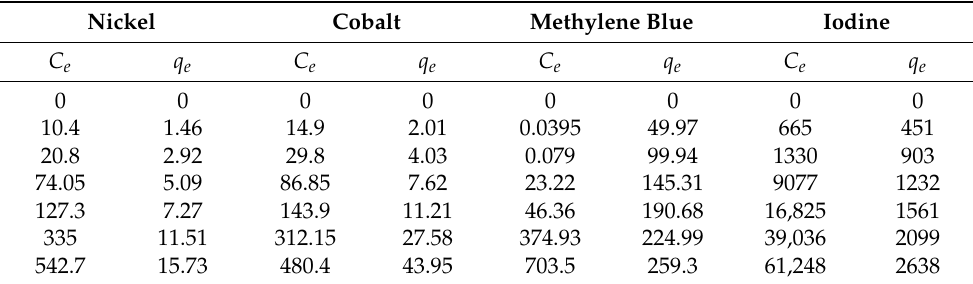
Table 2. q e and C e values for GAC samples charged with Ni, Co, MB and I 2 . Nickel